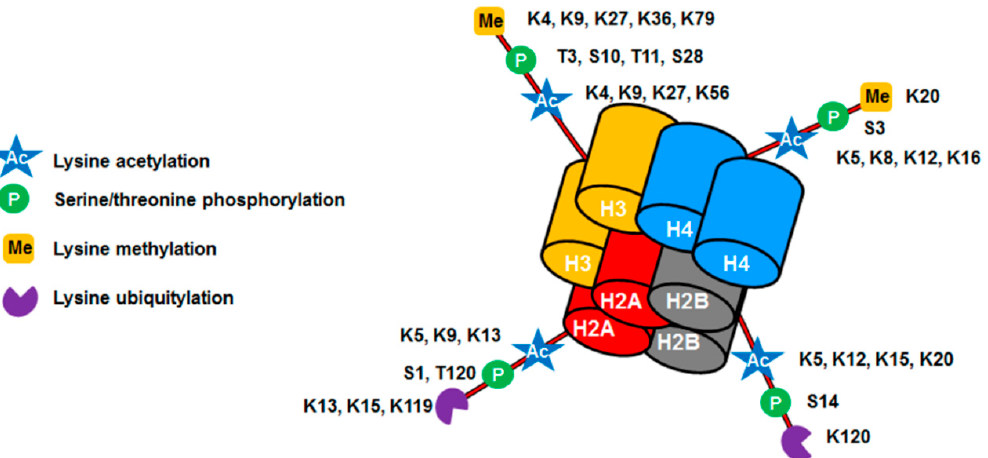
Figure 3. Nucleosome with histone post-translational modifications. Inside the nucleus DNA is wrapped into a protein complex known as chromatin. This protein complex (nucleosome) is composed of an octamer of four different histones (H3, H4, H2A, and H2B). Histones display a large number of modified residues (acetylation, methylation, phosphorylation and ubiquitylation). Through these modifications, chromatin becomes very dynamic, controlling the expression or repression of specific genes.